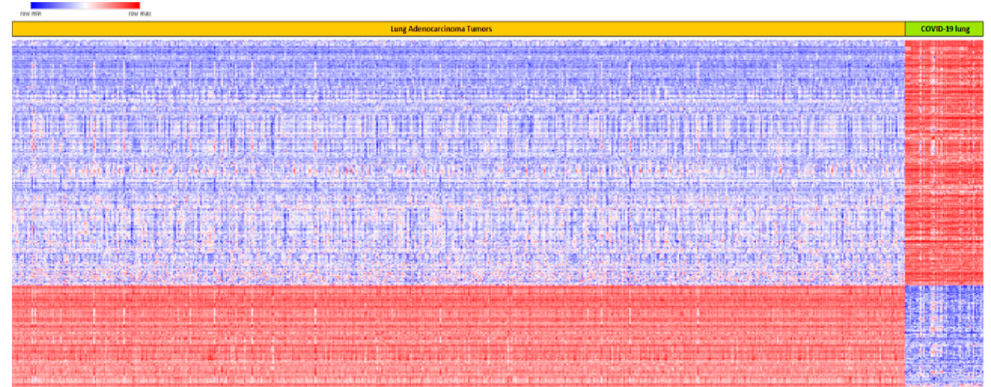
Figure 3. Patterns of expression profiles for the top 515 upregulated and downregulated genes in lung cancer and in COVID-19, generated using hierarchical clustering on genes associated with both diseases. Genes are represented in rows, and lung cancer and COVID-19 samples in columns. Red color indicates upregulation and blue represents downregulation.